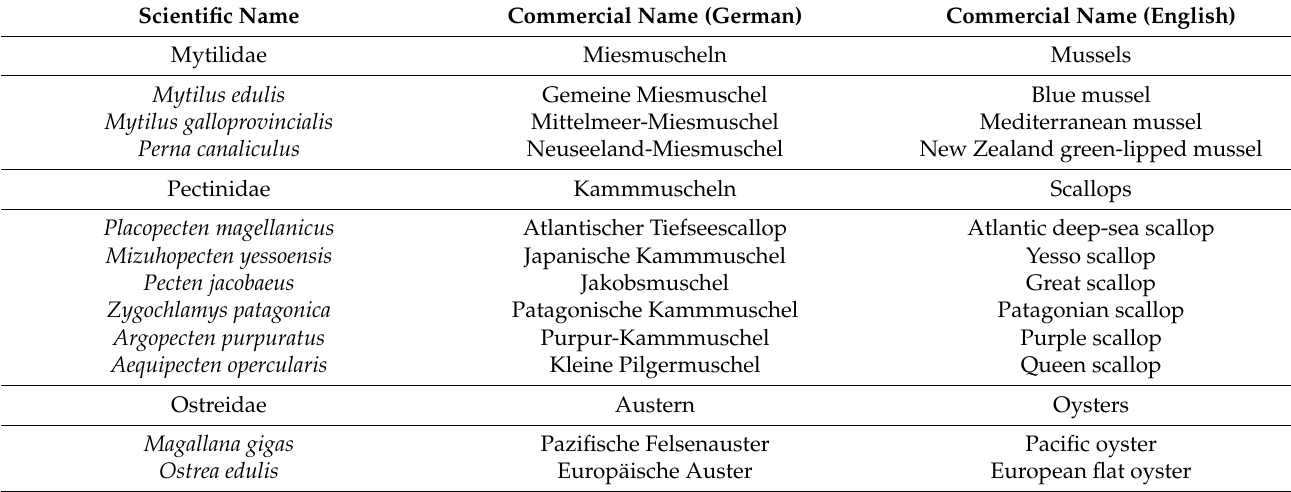
Table 1. Bivalve species used for development of the DNA metabarcoding method.